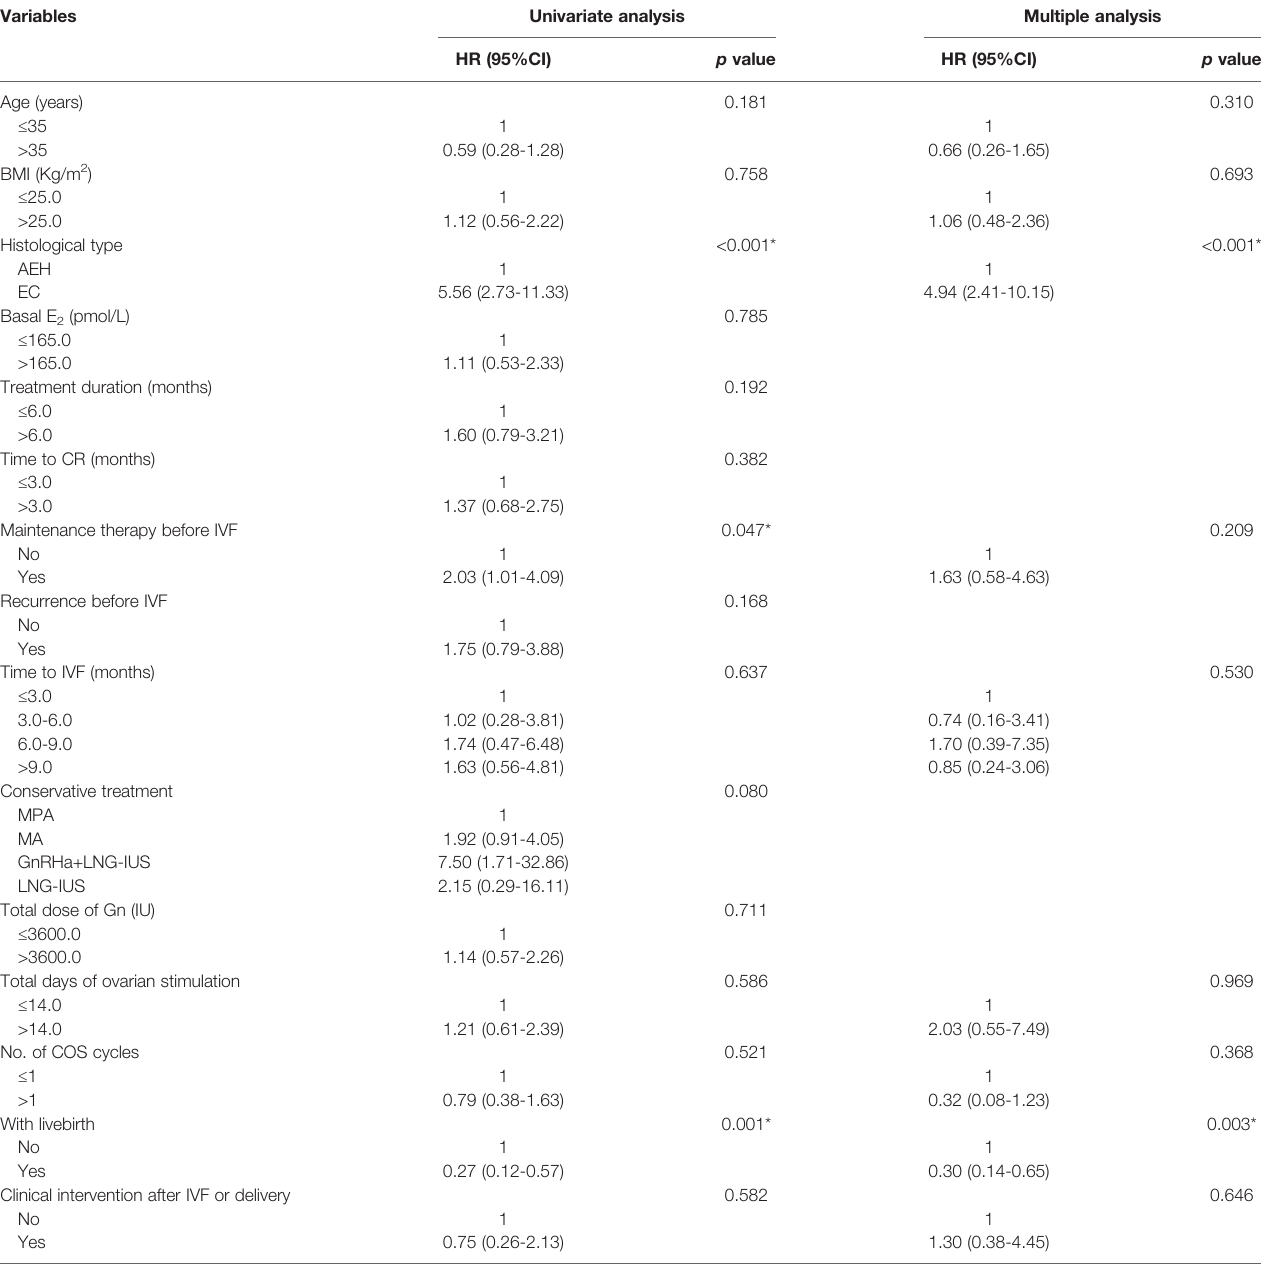
TABLE 3 | Univariate and multiple COX regression analysis of factors associated with recurrence.